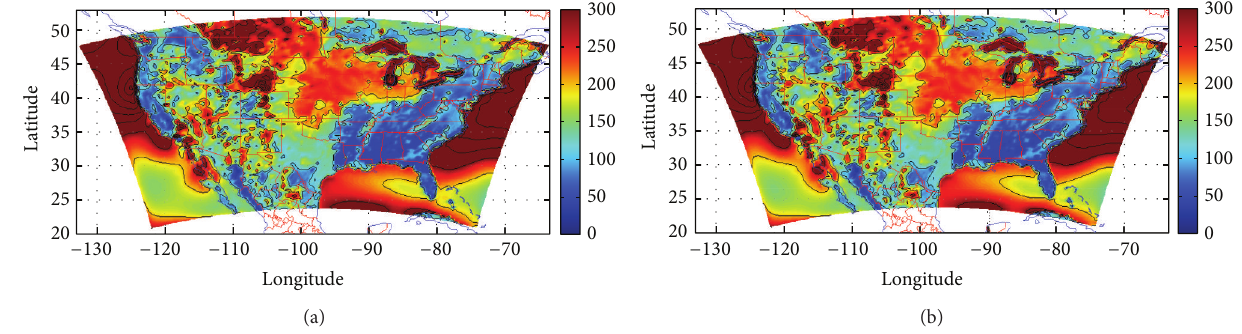
Figure 7: Dynamical downscaled average annual wind power density (Wm −2 ) from CCSM3 for (a) 2040s and (b) 2090s under the A1B climate scenario.